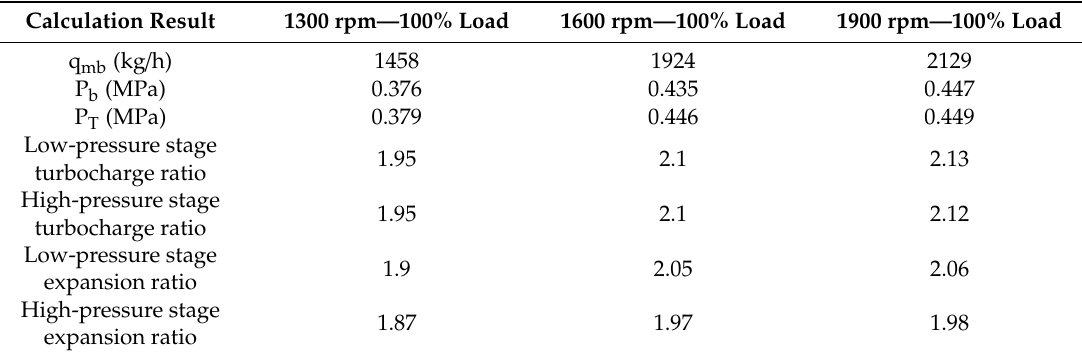
Table 3. Results of key parameters of the